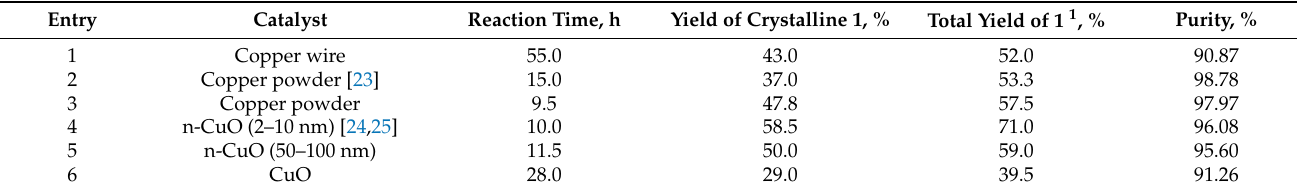
Table 1. Effect of catalysts on reaction time, yield, and quality of 1.